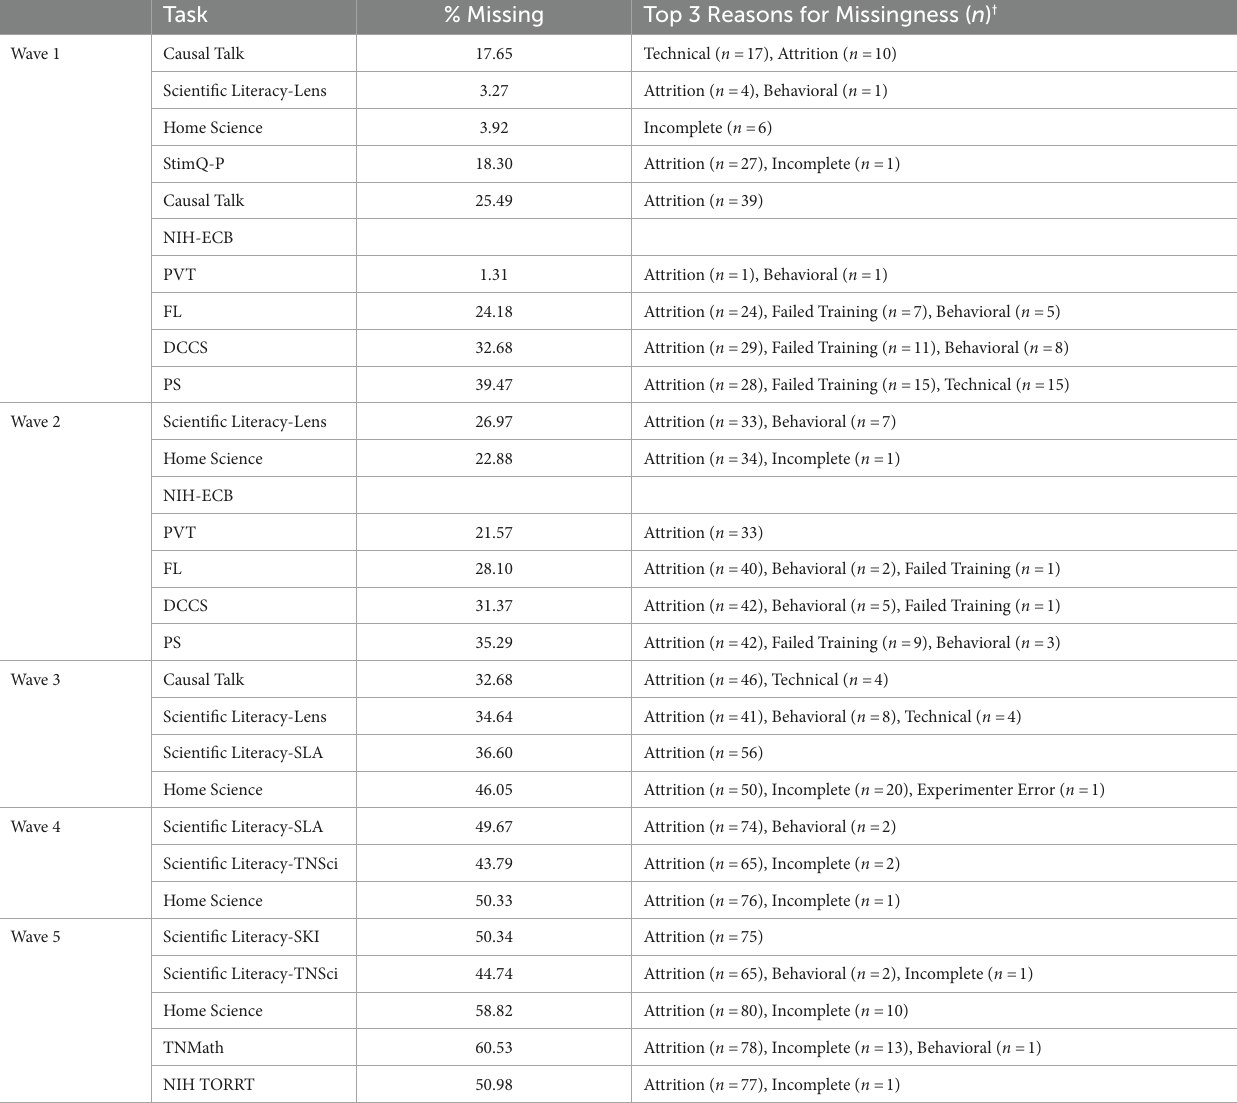
TABLE 2 Missing data (in percentages) and reasons for missingness. Task % Missing Top 3 Reasons for Missingness ( n )